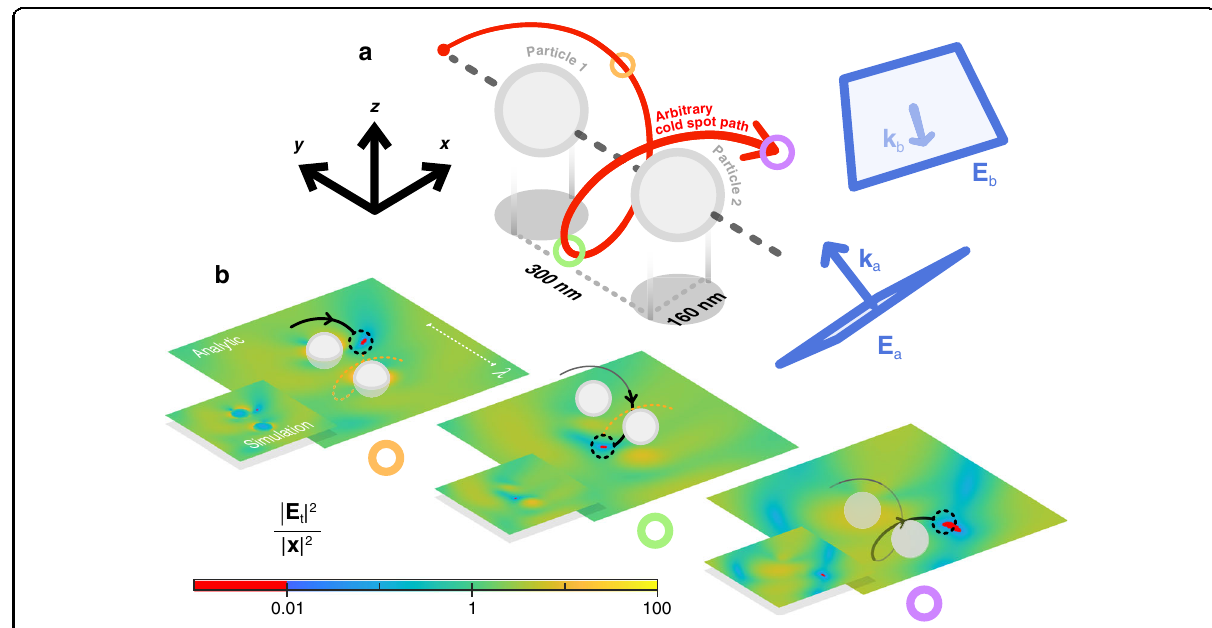
Fig. 2 Moving a cold spot around two silver point scatterers in a theoretical framework a Helical path taken by a cold spot around two silver nanoparticles, illuminated by two plane waves, E a and E b , with wavevectors k a ¼ k wavenumber k ¼ 2 π λ with λ ¼ 500 nm. The cold spot is moved along the path by changing x 1 (cid:2) 4 , manifesting as the polarisation, relative intensity, and phase of E a and E b . b Snapshots of the surrounding electric fi eld obtained at three positions on the helical path, marked by the coloured rings in (a). In the measured quantity, E t j j 2 , E t j j 2 is the intensity of the total electric fi eld and x j j 2 ¼ j E a j 2 þ j E b j 2 is the squared magnitude of the solution to x j j 2 A r 0 ð Þ x ¼ 0. The inset distributions present numerically simulated results of the same scenario, with plane wave polarisations identical to the analytical case. An animated version of this fi gure is found in the supplementary